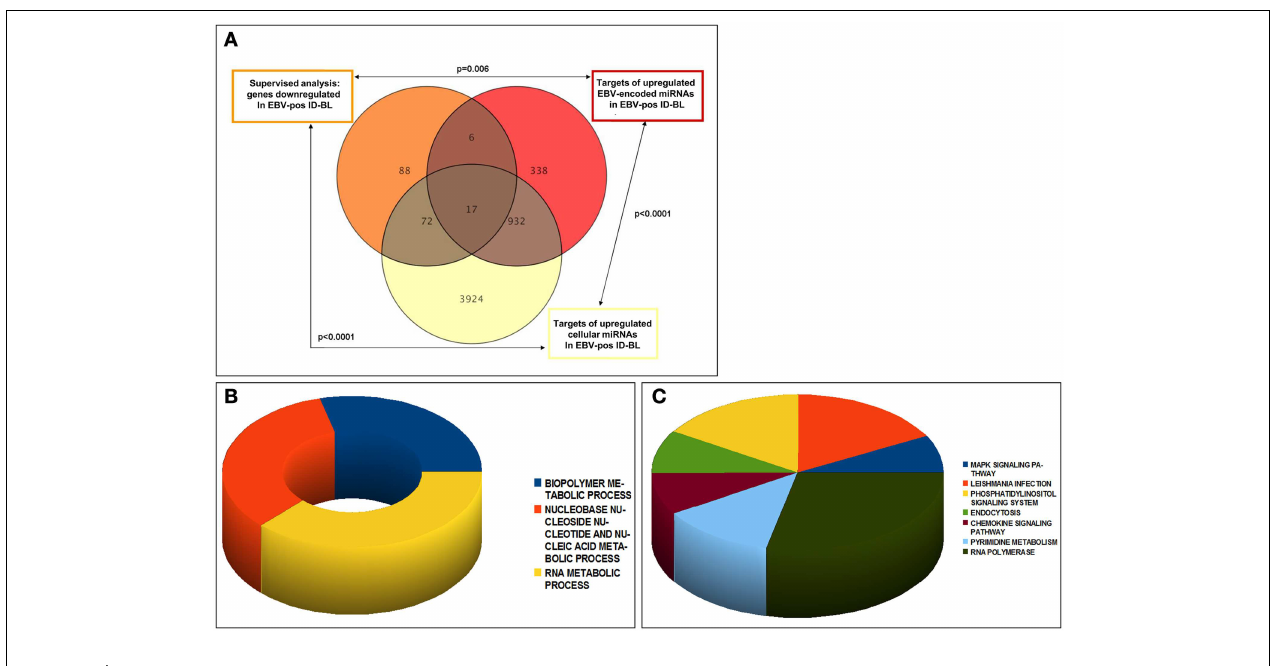
FIGURE 5 | Analysis of the experimentally validated targets of differentially expressed cellular and viral miRNAs. Genes targeted by the differentially expressed miRNAs between EBV-positive and EBV-negative ID-BLs were significantly over-represented among genes differentially expressed between the same two tumor